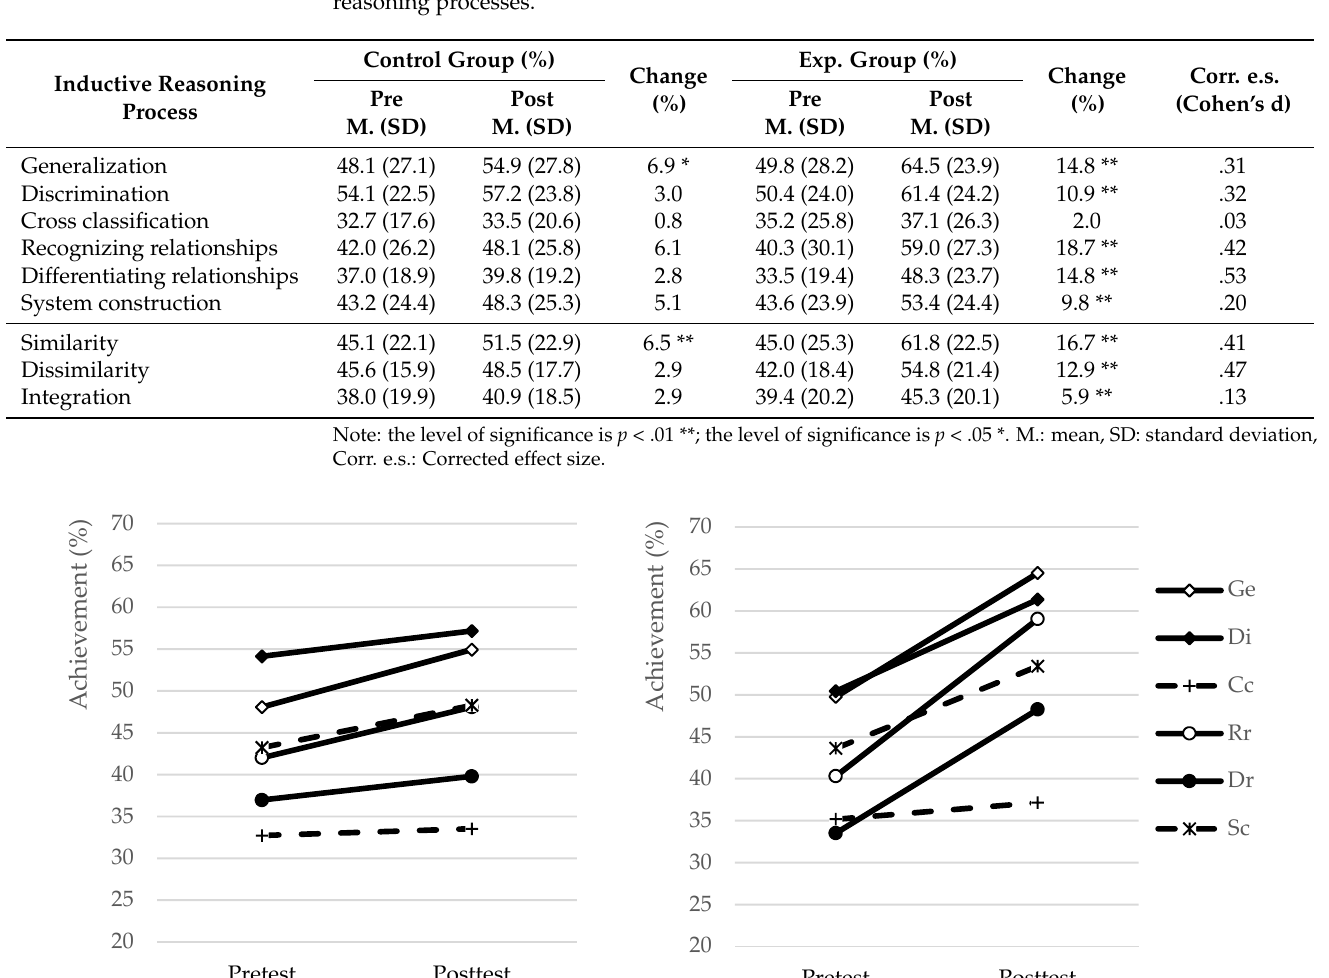
Table 7. Changes in the achievements of the control and the experimental group in the inductive reasoning processes.